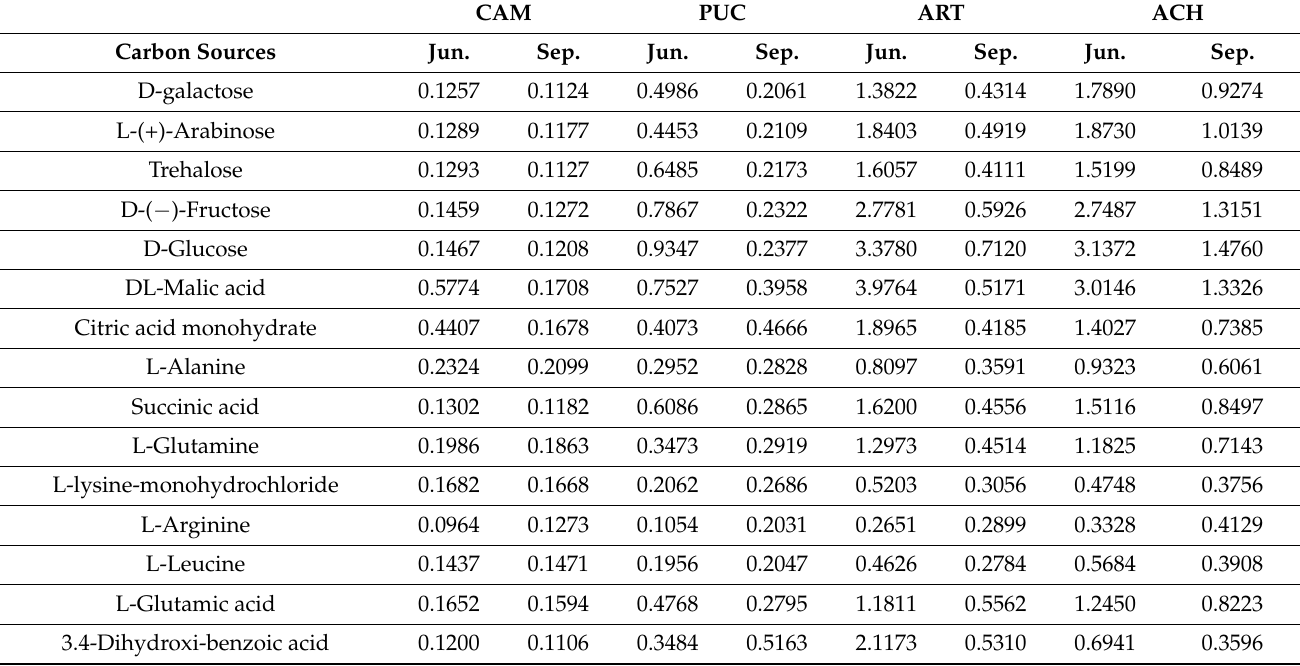
Table A1. Substrate-induced respiration rates ( µ g CO 2 -C/g soil/h) of soil microbial communities of the four salt-affected habitat types at Apajpuszta, Hungary (each value is an average of 3 replicate measurements). Jun. = June, Sep. = September.